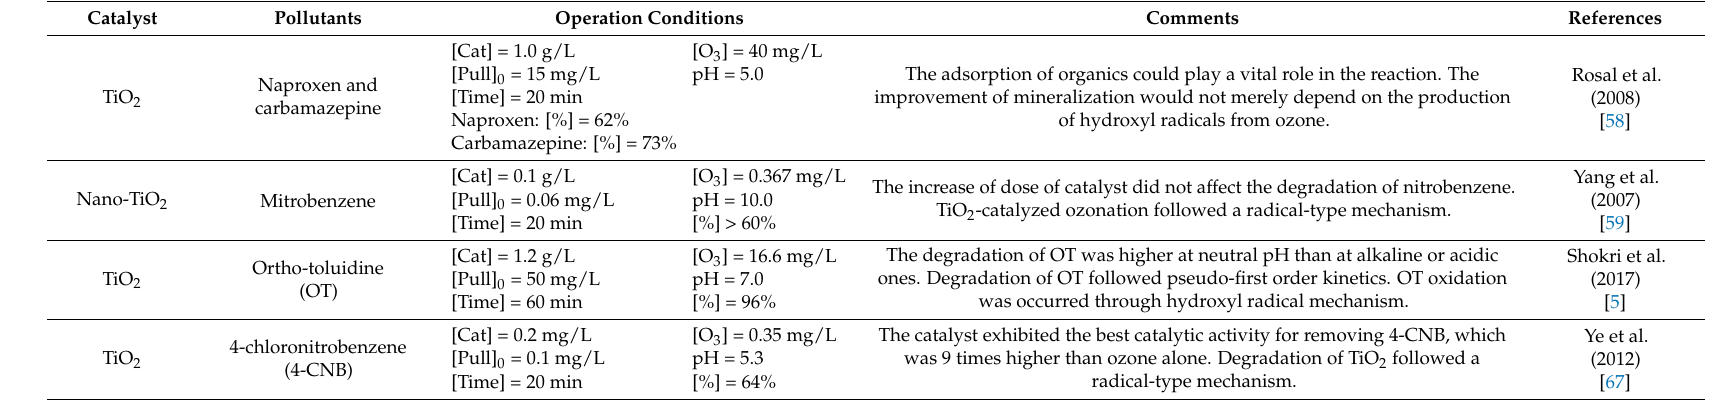
Table 4. Titanium dioxide for catalytic ozonation